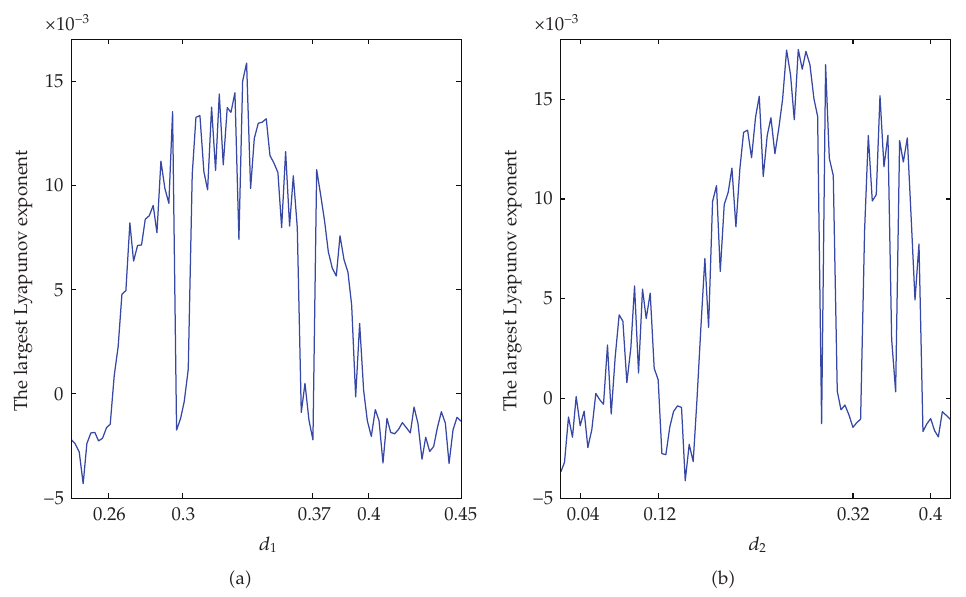
Figure 9: The largest Lyapunov exponent of system (cid:3) 1.2 (cid:6) : (cid:3) a (cid:6) 0 . 24 < d 1 < 0 . 45; (cid:3) b (cid:6) 0 . 02 < d 2 < 0 .